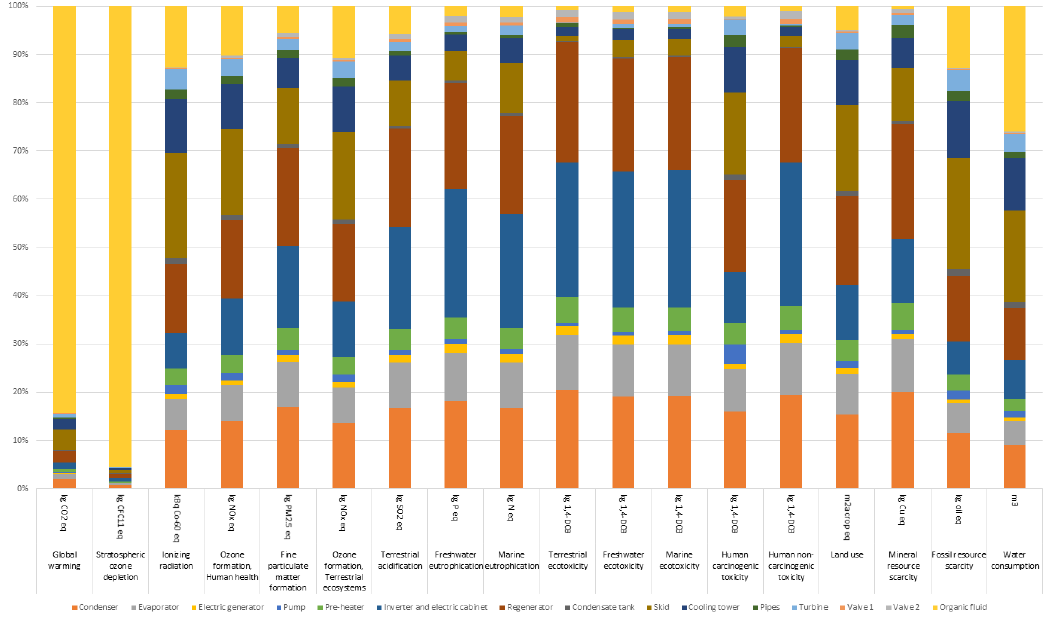
Figure 7. Contribution on the different impact categories of ORC devices construction and operation. Results are obtained with ReCiPe 2016—Midpoint (H) method.